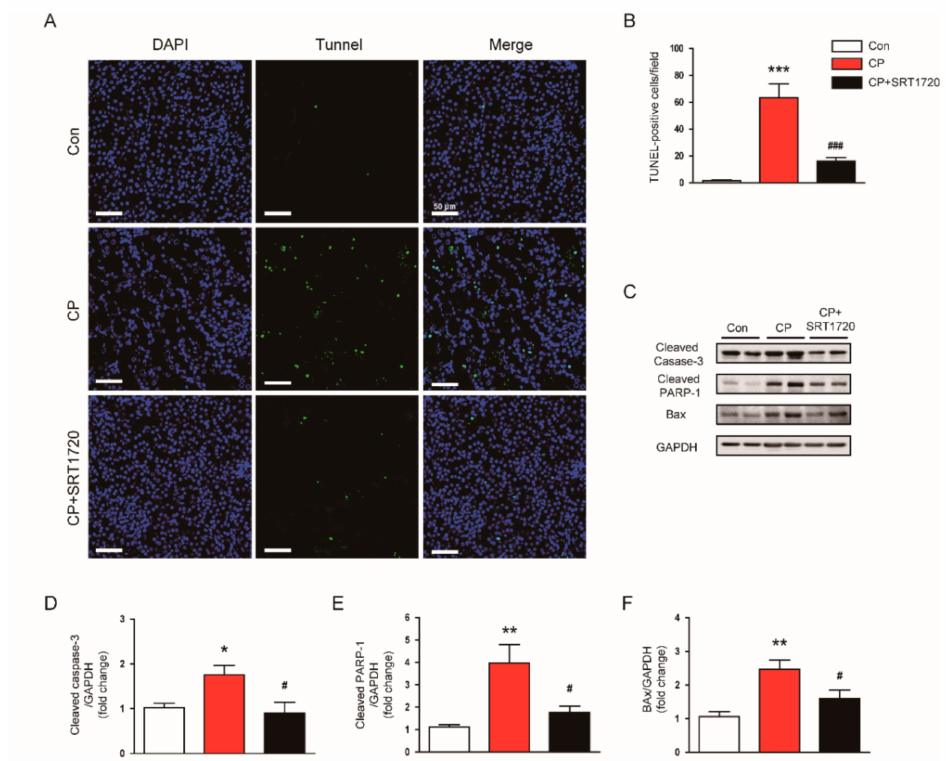
Figure4. EffectsofSRT1720onapoptoticcelldeathinkidneysofmicetreatedwithcisplatin. ( A )Representative imagesofterminaldeoxynucleotidyltransferase-tediateddeoxyuridinetriphosphatenickendlabeling(TUNEL) staining. Scale bar: 50 µ m. ( B ) Number of TUNEL-stained cells. ( C ) Western blots of cleaved caspase-3, cleaved poly(ADP-ribose) polymerase-1 (PARP1), and Bax levels in kidneys. ( D ) Quantification of cleaved caspase-3 level. ( E ) Quantification of cleaved PARP1 level. ( F ) Quantification of Bax level. * p < 0.05, ** p < 0.01,